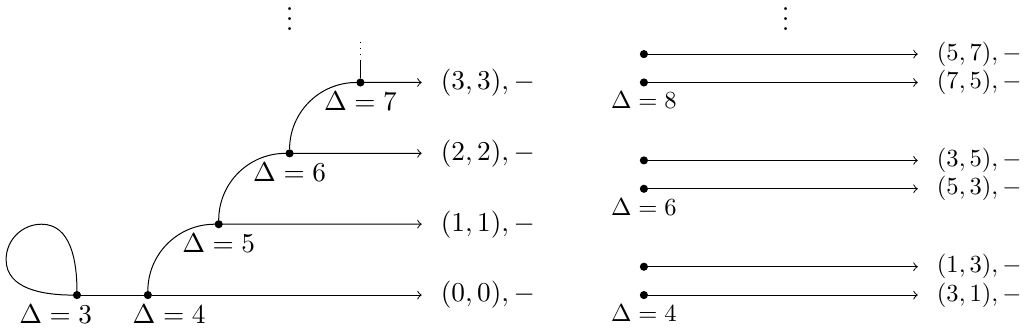
Figure 4 . Topology of (cid:6) in charged sector after taking into account poles. The dimensions shown near intersections correspond to the block which appears as the